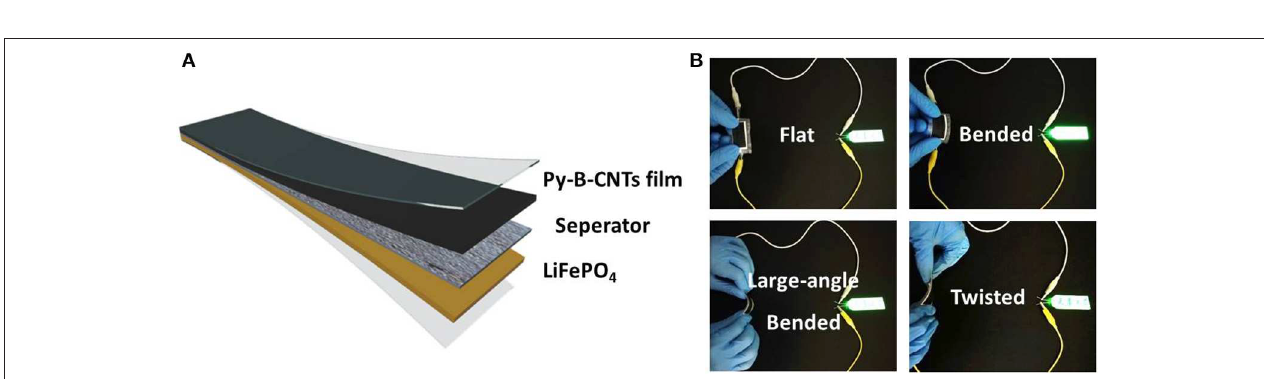
FIGURE 5 | (A) Schematic illustration of the flexible LIB with py-B-CNTs film and commercial LiFePO 4 as electrodes; (B) photographs of the flexible LIB powering a light-emitting diode board under various bending